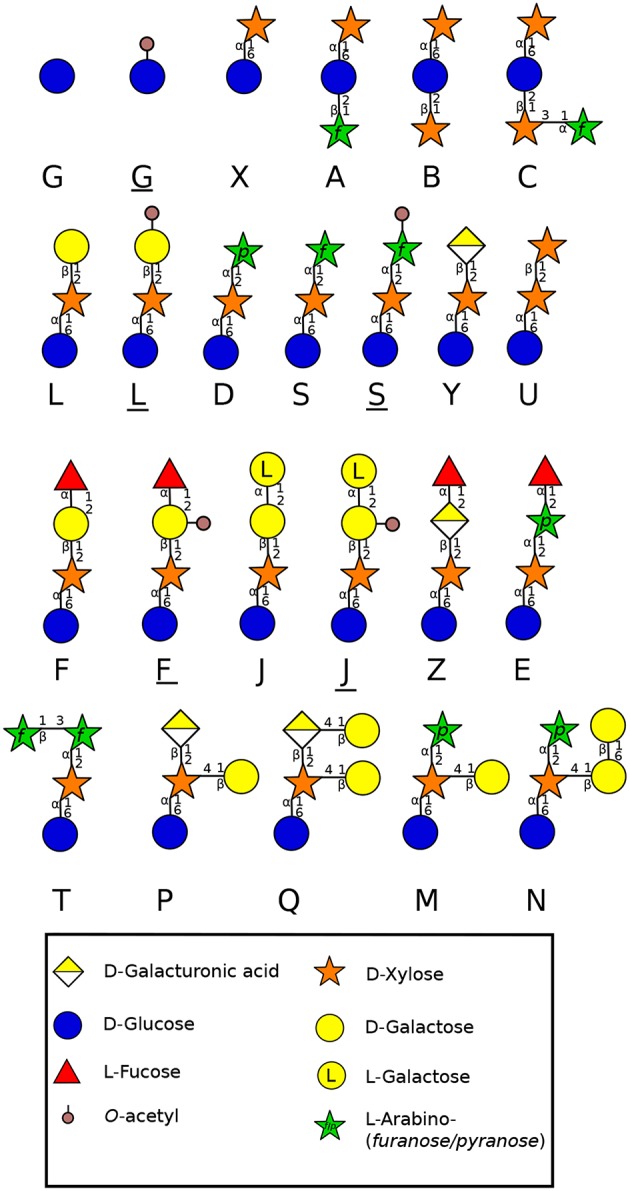
Side chain diversity found in XyG throughout land plant lineages according to Schultink et al. (2014) using the one letter code proposed by Fry et al. (1993). Underlined letters correspond to O-acetylated side chains. Monosaccharides are represented according to the Symbol Nomenclature for Glycans (SNFG) (Varki et al., 2015).